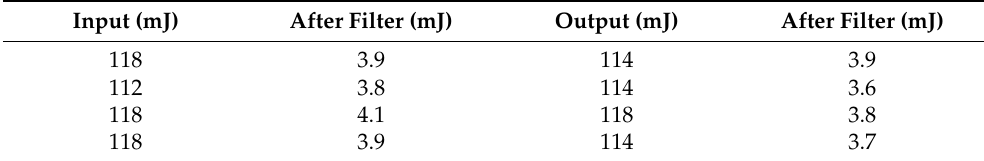
Table 2. Air transmission attenuation test of ArF laser.